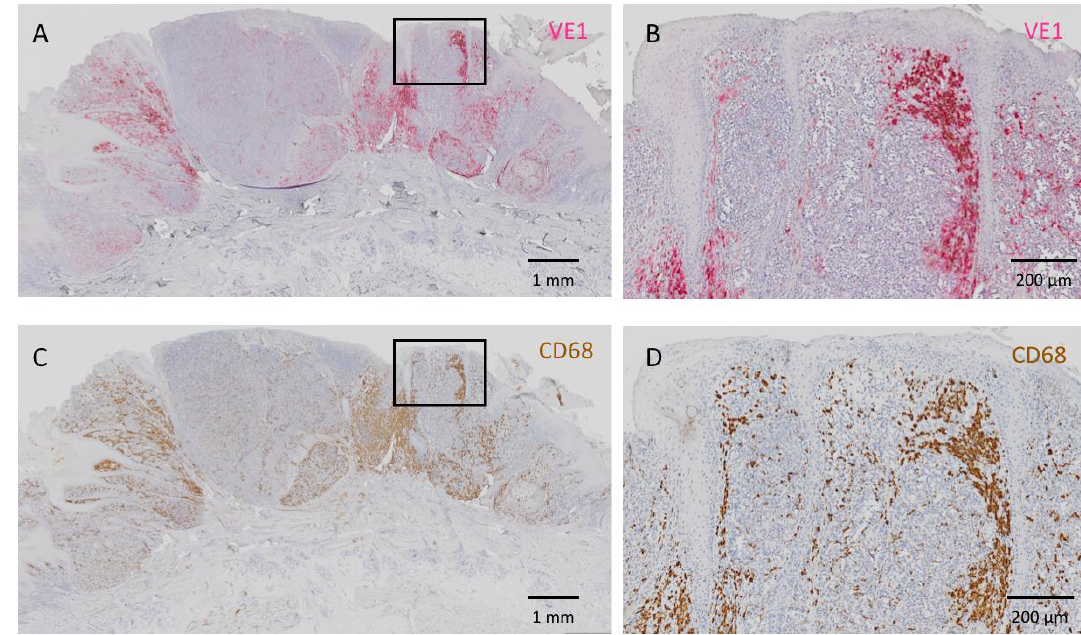
Figure 3 Figure 3. A negative case of VE1 staining. Some cells show strong VE1 expression in red ( A , B ), but CD68 staining clearly highlights that these VE1-positive cells are macrophages ( C , D ). No melanoma cells stain with VE1 and this case should be regarded as “negative” for VE1. ( B ) High-powered view of the rectangular area in A . ( D ) High-powered view of the rectangular area in C . Bars indicate 1 mm in A , C and 200 µ m in B , D